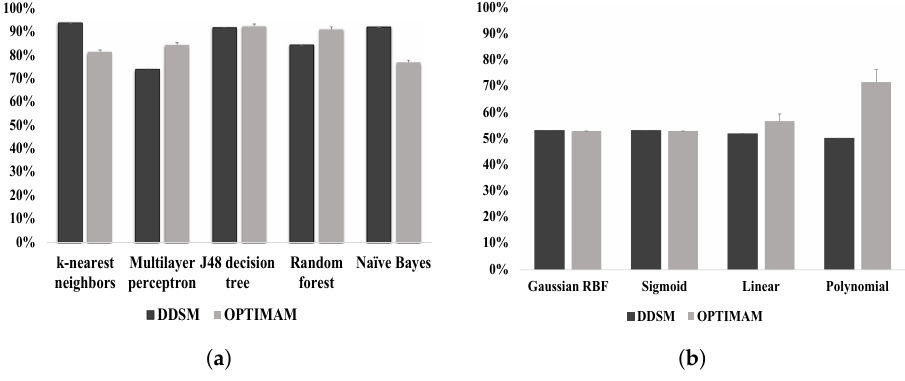
Figure 10. The accuracy of microcalcification cluster classification by individual classifiers: ( a ) classification accuracy for k-nearest neighbor, Multilayer perception, J48 decision tree, Random forests, and Naive bayes; and ( b ) classification accuracy by SVM using four different kernels: Gaussian RBF, Sigmoid, Linear, and